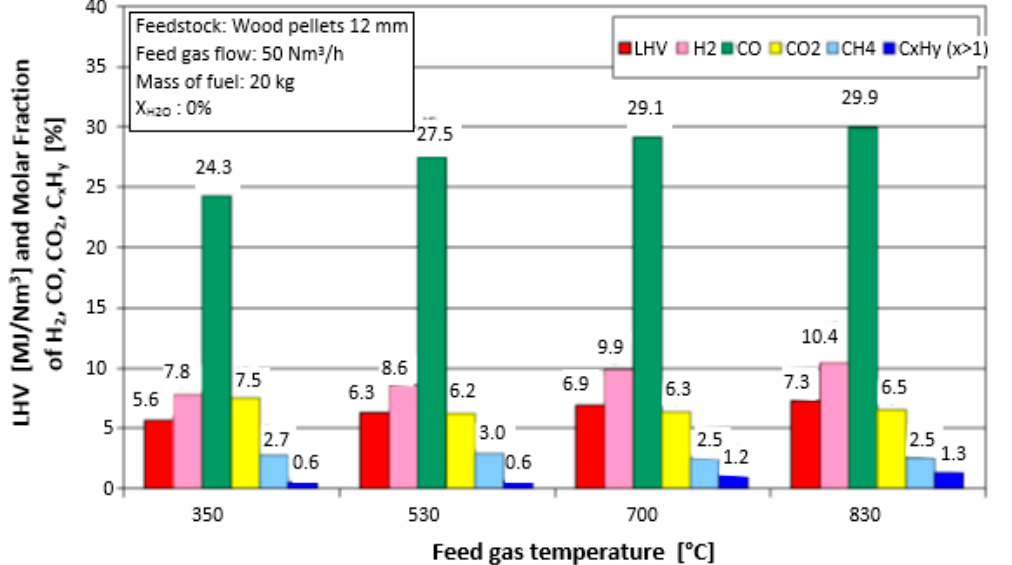
Figure 10. Influence of the feed gas temperature on the average values of LHV and composition of dry fuel gas (gasification 20 kg of 12 mm wood pellets—computed results).